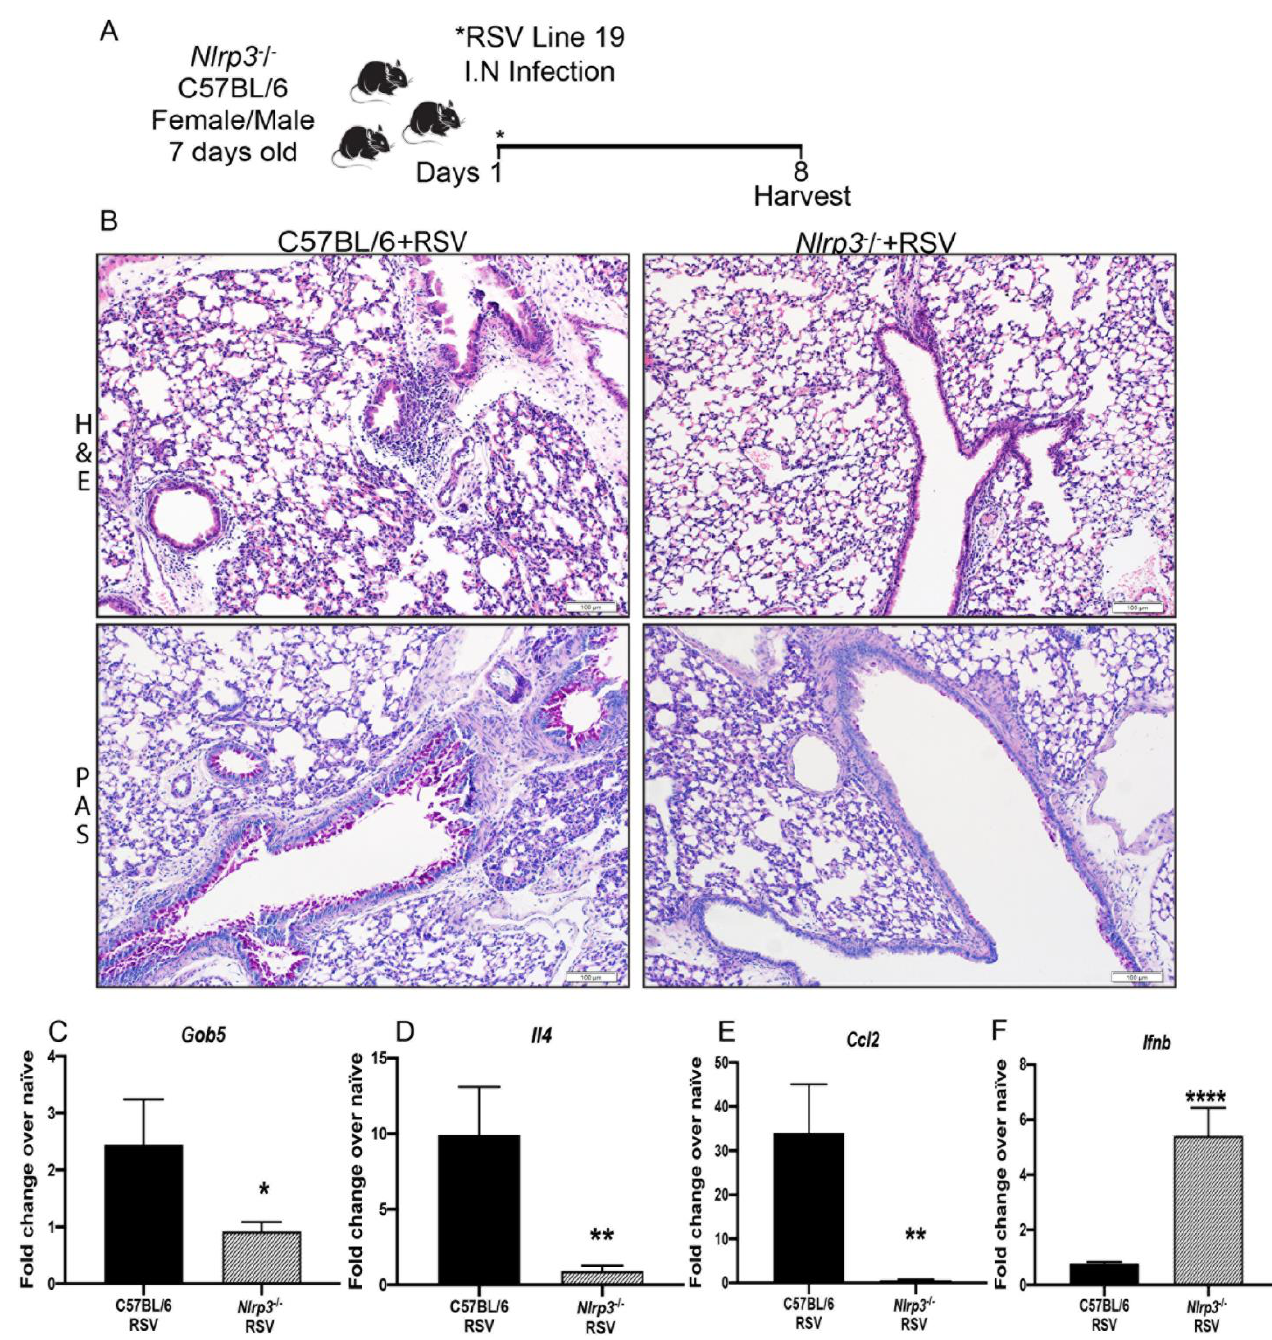
Figure 5. Decreased RSV immunopathology in Nlrp3−/− neonate mice. ( A ) 7-day old Nlrp3−/− or C57BL/6 neonatal mice were infected intranasally with Respiratory Syncytial Virus (RSV), Line 19. ( B ) Lung histopathology in Hematoxylin and Eosin stain (H&E) showed strongly reduced lung inflammatory infiltration and Periodic acid-Schiff stain (PAS) detected mucus that was decreased in the Nlrp3−/− mice compared with control C57BL/6. Scale bar = 100 μm. ( C ) Decreased Gob5 lung mRNA expression and ( D ) IL-4 , ( E ) Ccl2 , ( F ) Upregulated lung expression of Ifnb. Data represent the Mean ± SEM from 4 to 8 mice (experimental repeats 2). * p ≤ 0.05, ** p ≤ 0.01, **** p ≤ 0.0001.